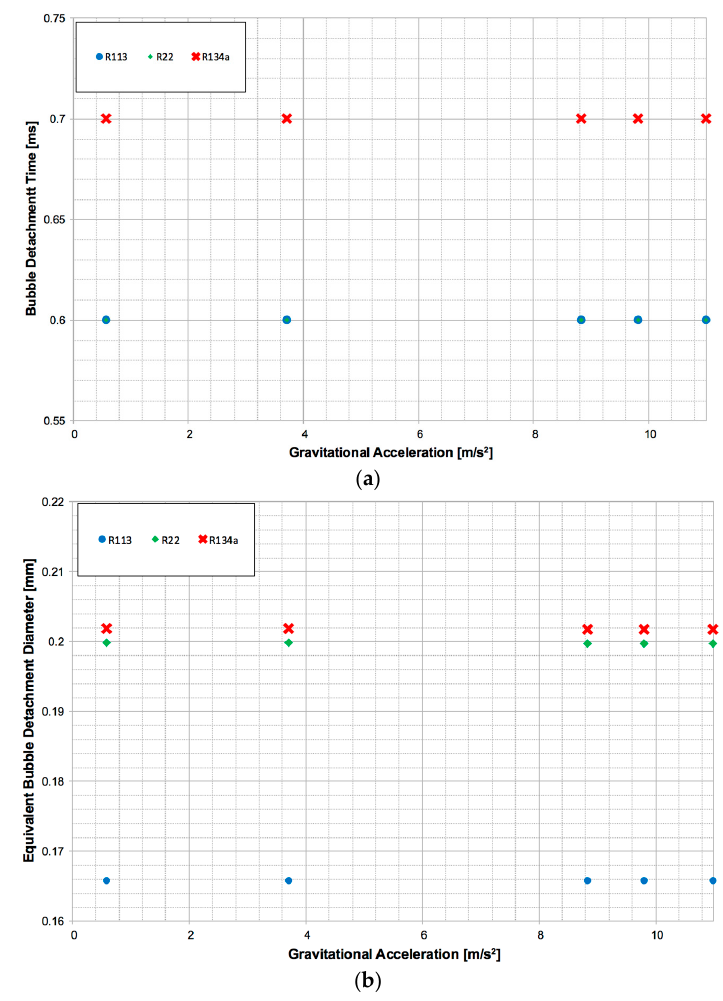
Figure 27. Effect of gravity level on: ( a ) the bubble detachment time; ( b ) the equivalent bubble detachment diameter (cases D16–D30, with the 5 bar ambient pressure condition).